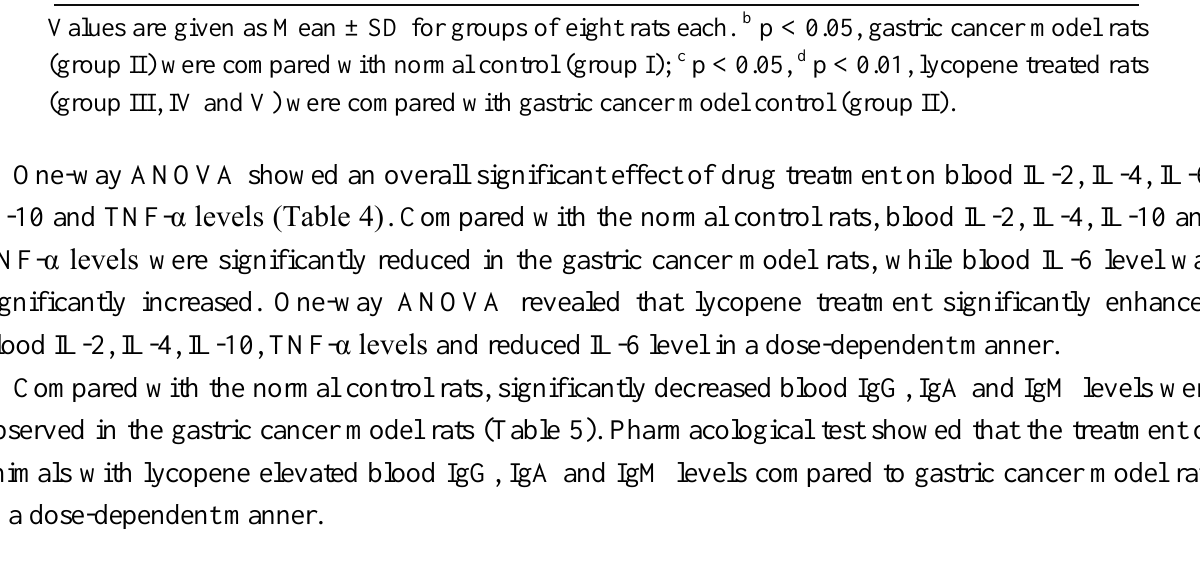
Table 4. Effect of Lycopene treatment on blood IL-2, IL-4, IL-10, IL-6 and TNF-α levels in gastric cancer rats.